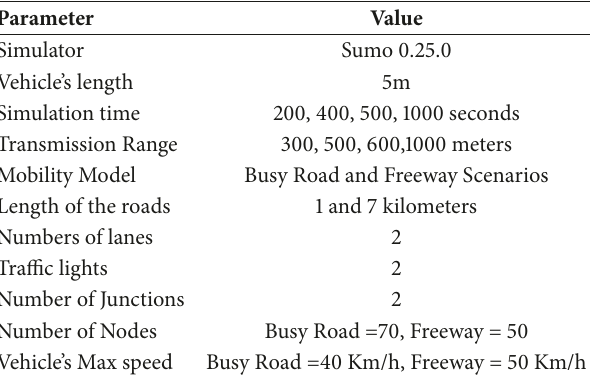
Table 4: Road traffic generation